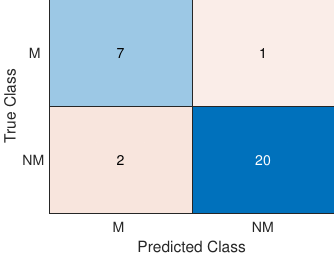
Figure 7. Confusion matrix of validation